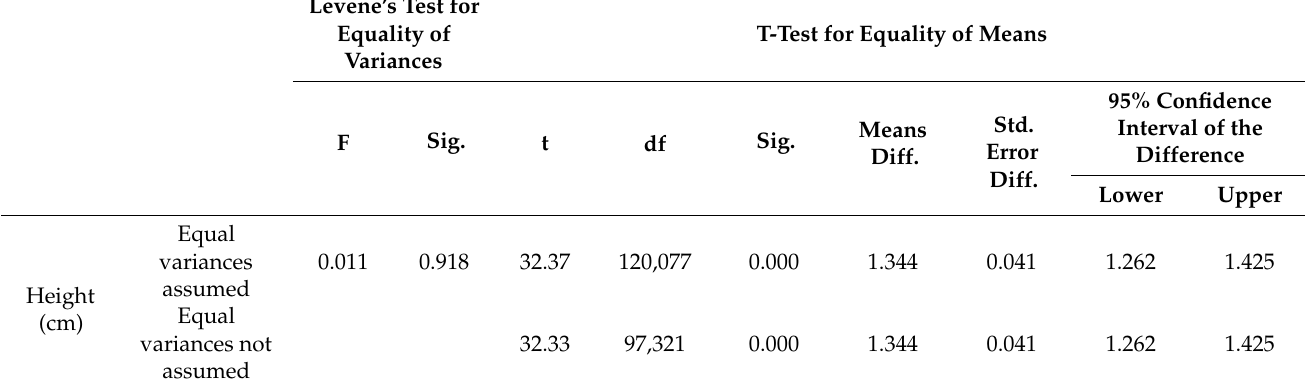
Table 2. T-test for equality of means in the sample Extremadura (urban and rural